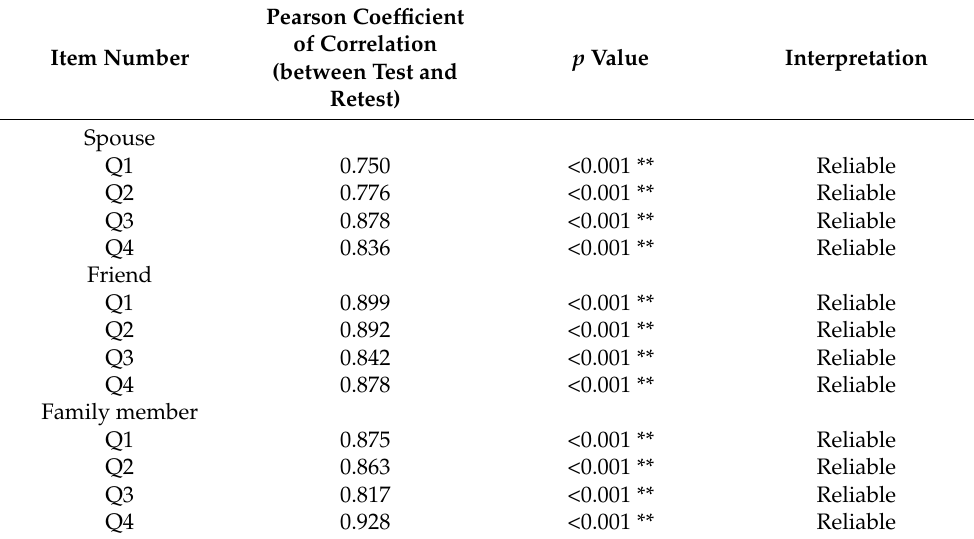
Table 5. Results of the test–retest reliability (external consistency) of NRQ-INA.